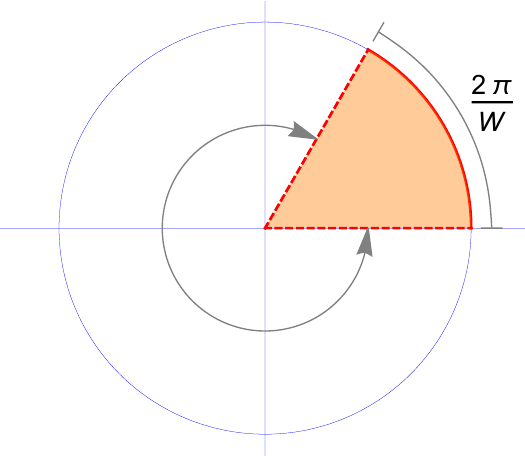
Figure 1 . Orbifold B 4 / Z W . This is a slice of the unit ball in E 4 where the sides (red dashed lines) are identified. The boundary is only composed of the arc of the circumference r = 1 (red solid